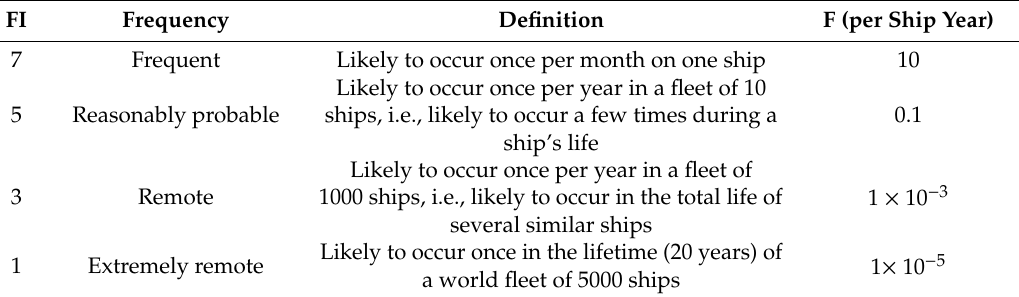
Table 1. Definition of frequency index [21].